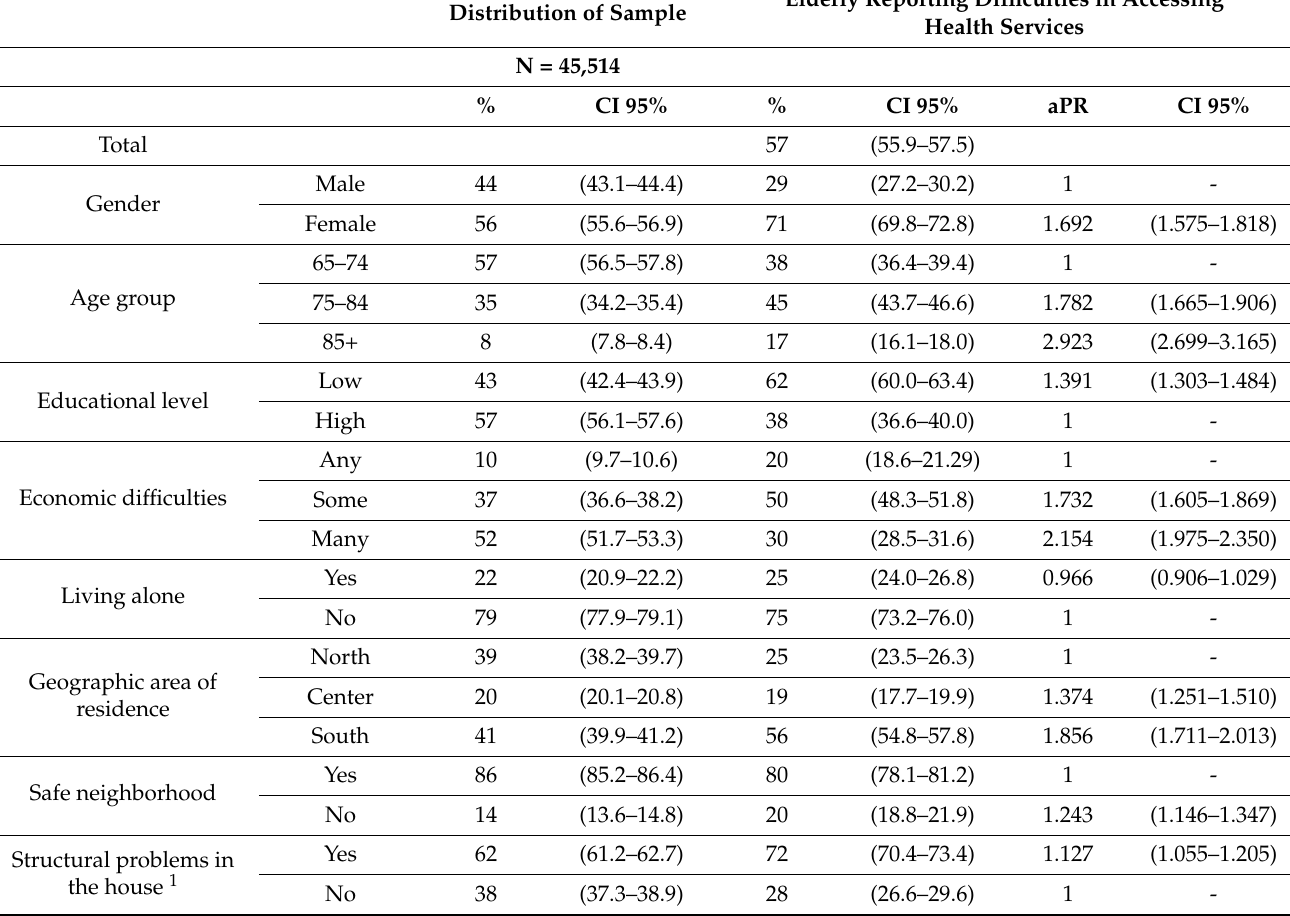
Table 3. Characteristics of elderly reporting difficulties in accessing health services and